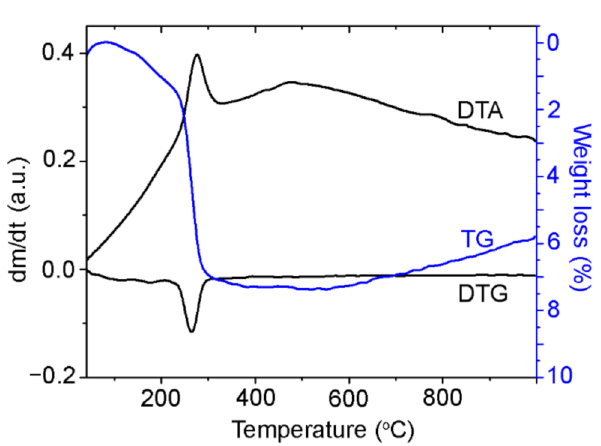
Figure 10. Differential thermal analysis (DTA), differential thermogravimetric analysis (DTG), and thermogravimetric (TG) curves for VA/CeO 2